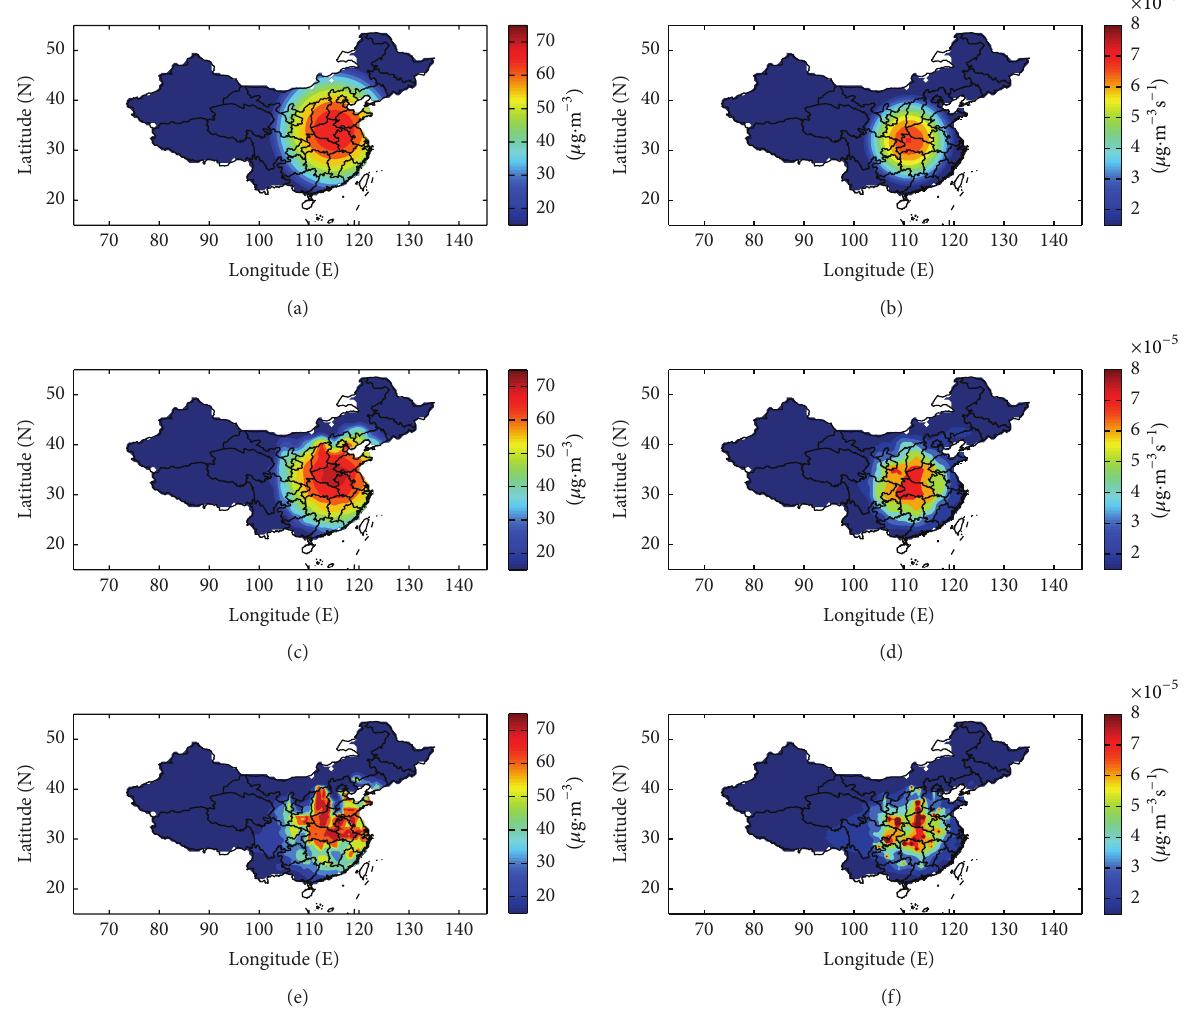
Figure 2: (a) The prescribed IC, (b) the prescribed SS, (c) the inverted IC in TE1, (d) the inverted SS in TE2, (e) the inverted IC in TE4, and (f) the inverted SS in